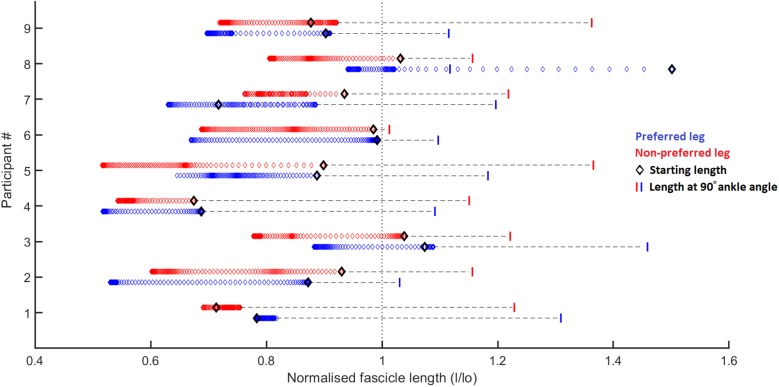
Fascicle length changes normalized to the resting fascicle length [measured at tendon slack length (data from Aeles et al., 2017)] for the preferred (blue) and non-preferred (red) leg for each participant. Each diamond represents a single data point, 1 for every 1% of the stance phase. The black diamond represents the fascicle length at the start of the ground contact phase. The vertical bars represent the fascicle length at a 90° ankle joint angle (in relaxed state, data from Aeles et al., 2017). The figure shows that most participants have little to no stretching of the fascicles following ground contact, other than participant 7 in the preferred leg. It also shows significant shortening of the fascicles in some participants (e.g., participant 2), whereas in others the fascicles behave mostly isometrically (e.g., participant 1). For all participants the fascicles at the end of the ground contact sit at (much) shorter lengths than their slack length (vertical dotted line). Considering that all participants had an ankle angle that is more dorsiflexed than 90° at initial ground contact, it is obvious that there is already considerable shortening of the fascicles (other than the preferred leg in participant 8) prior to ground contact due to pre-activation of the muscle, as shown by the horizontal dashed lines.